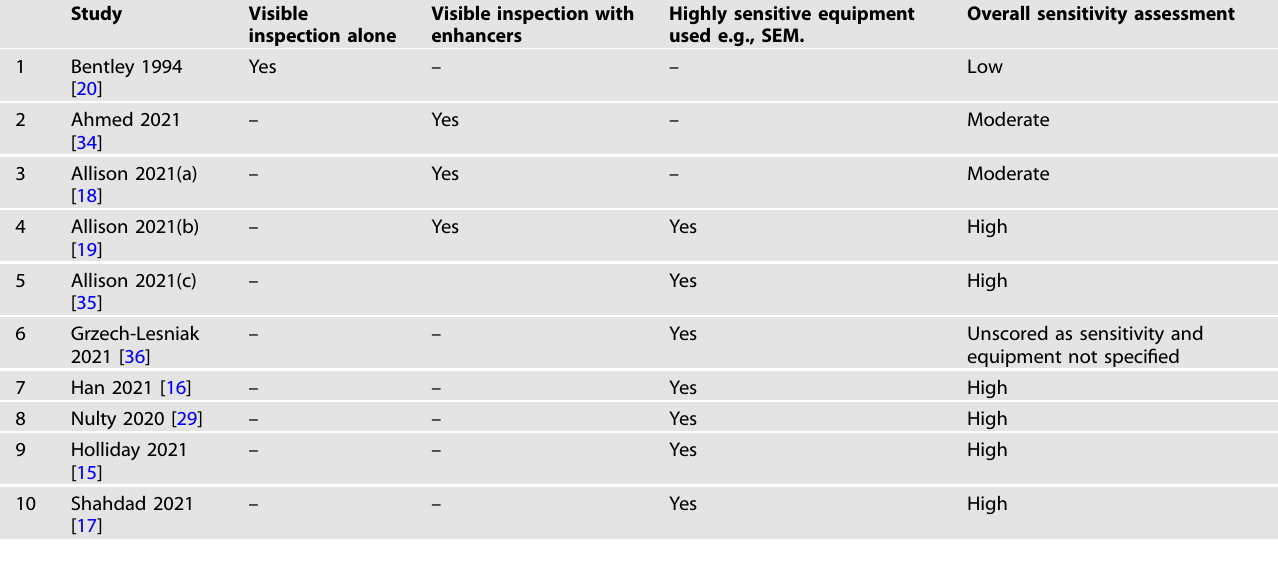
Table 6. Sensitivity measure of studies used other methods to measure contamination (non-microbial/ non-blood based) ( n = 10). Study